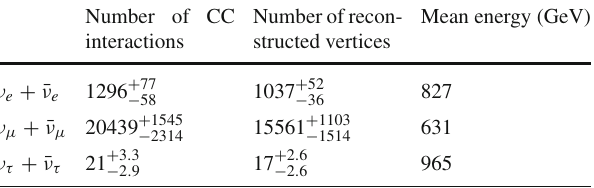
Table 2 The expected number of neutrinos with E ν > 100 GeV inter- actingthroughCCprocessesinFASER ν ,theexpectednumberofrecon- structed vertices in FASER ν requiring n tr ≥ 5, and the mean energy of neutrinos that interact in FASER ν . Here we assume a benchmark detec- tor made of tungsten with dimensions 25cm × 25cm × 1m at the 14 TeVLHCwithanintegratedluminosityof L = 150fb − 1 .Reductionsin the number of reconstructed vertices from the geometrical acceptance and lepton identification efficiency have not been included. The uncer- tainties correspond to the range of predictions obtained from different MC generators Number of CC Number of recon- interactions structed